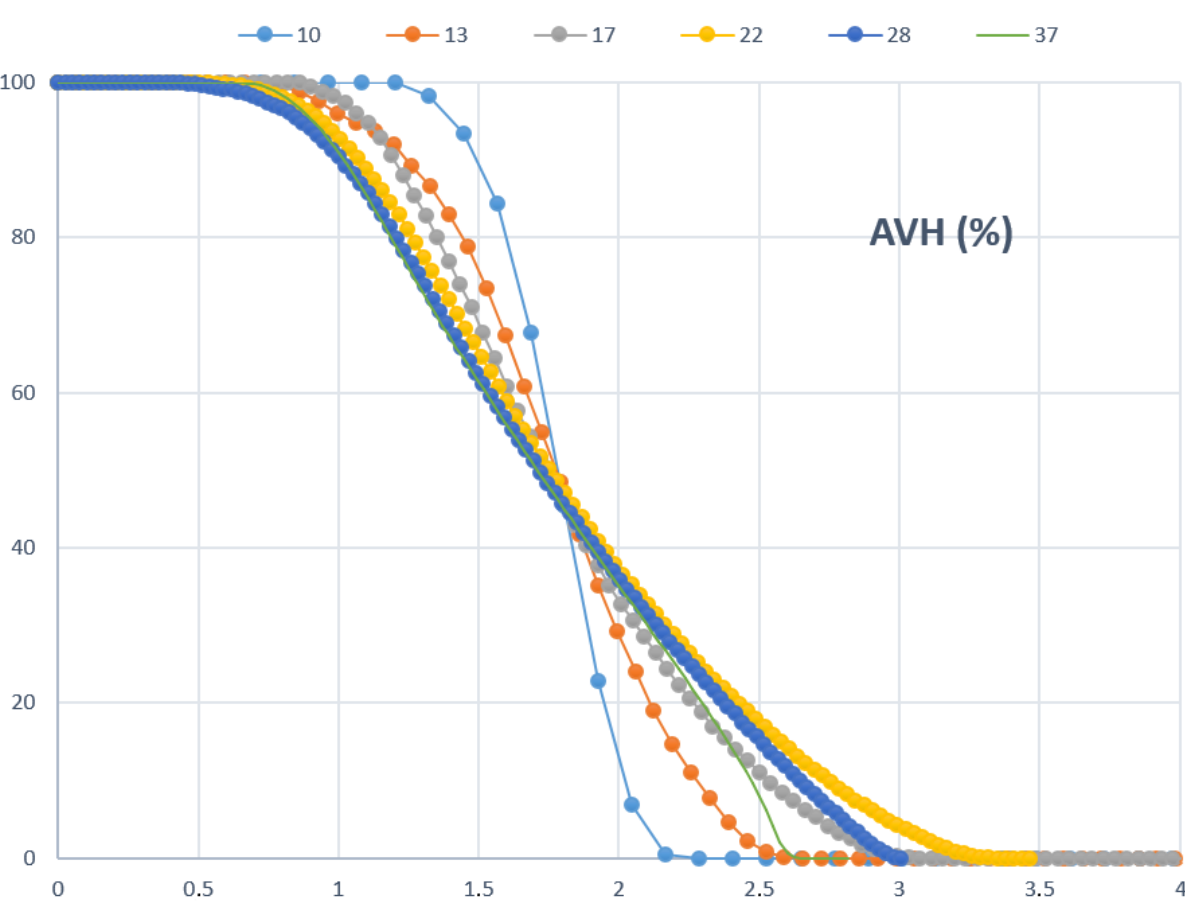
Table 4. Recovered activities for the liver and the three spherical lesions in the Abdo-Man